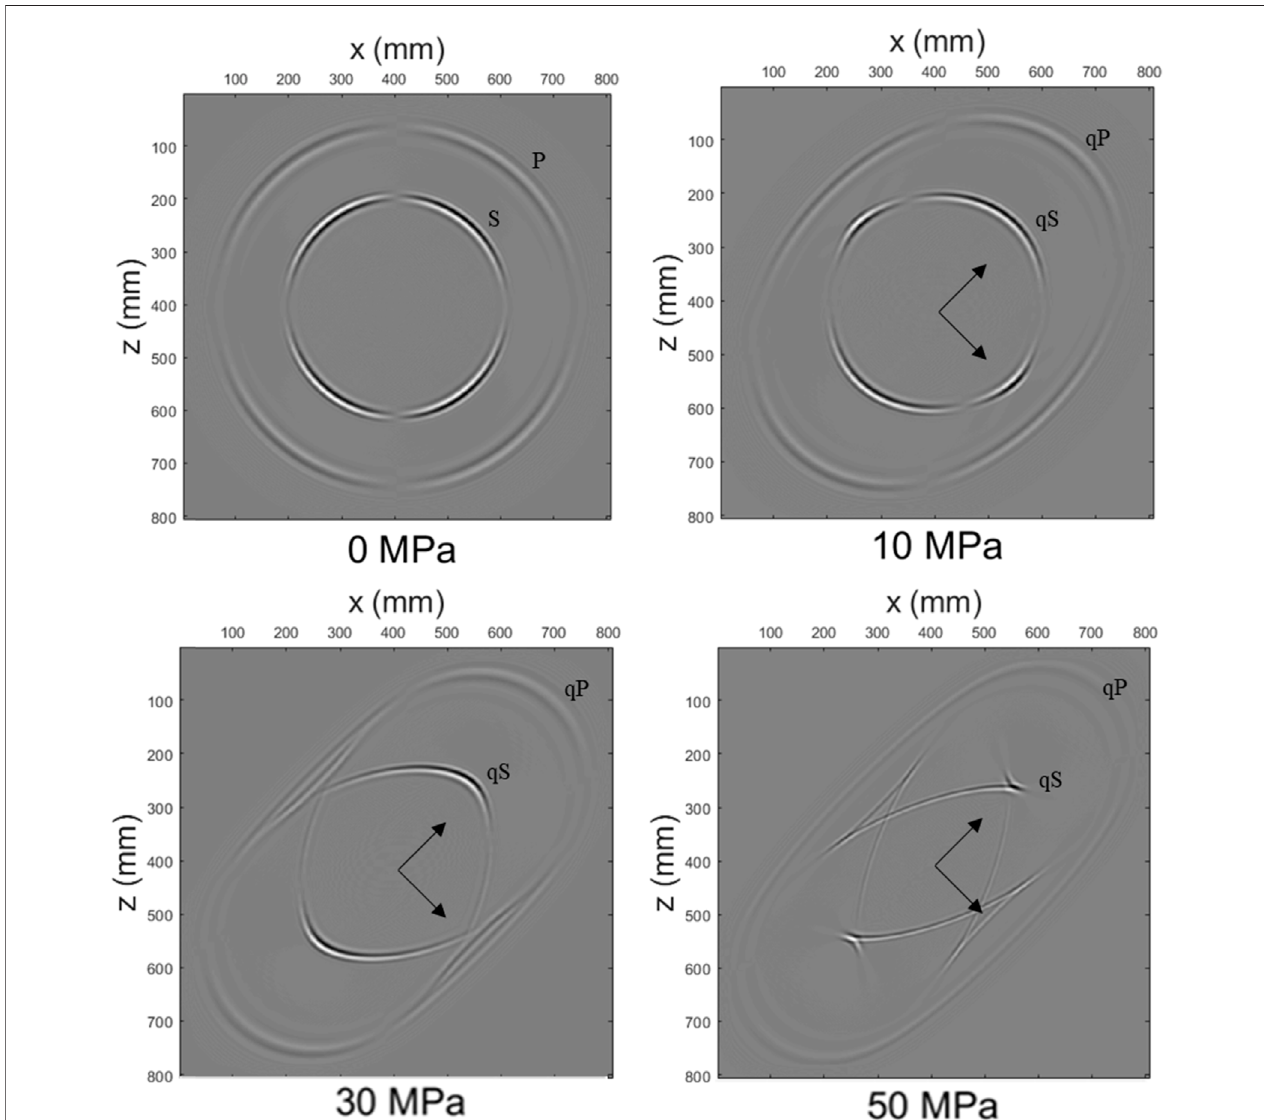
FIGURE 10 | Wave fi eld snapshots of the x -component of the particle velocity at t = 0.12 ms for various simple shear stresses. The arrow indicates the principal strain direction calculated by Eq. 49 .